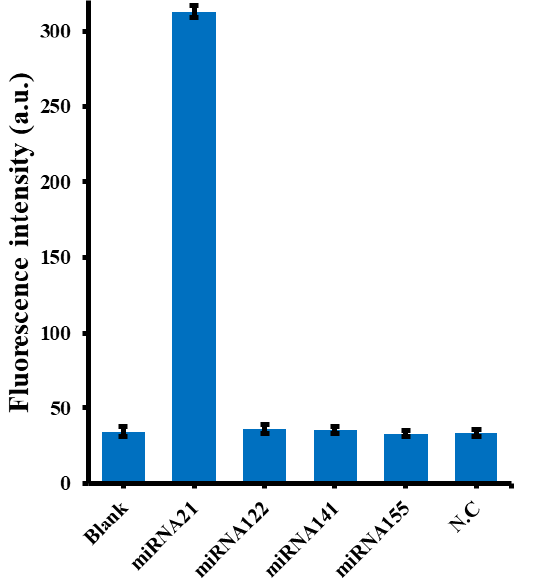
Figure 4. Specificity of the proposed sensor for miRNA-21 compared to other interfering RNA strands. The concentration of miRNA-21 was 10 nM, the concentrations of each interfering RNA strand (miRNA122, miRNA141, miRNA155 or N.C) were 10